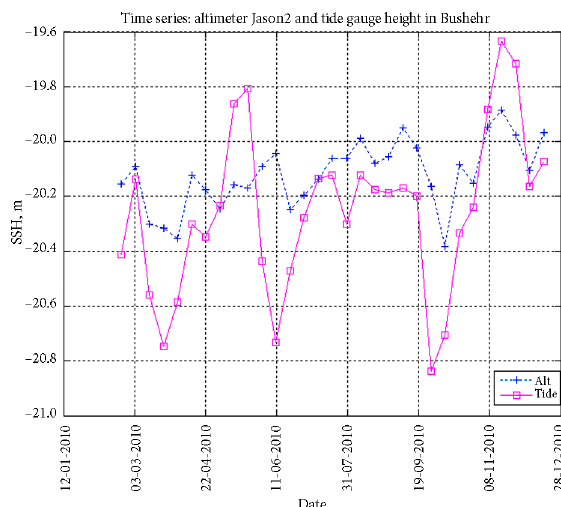
Fig. 7. Sea surface height time series obtained from jason-2 against those of Bushehr tide gauge over a 1-year time span from 2010 to